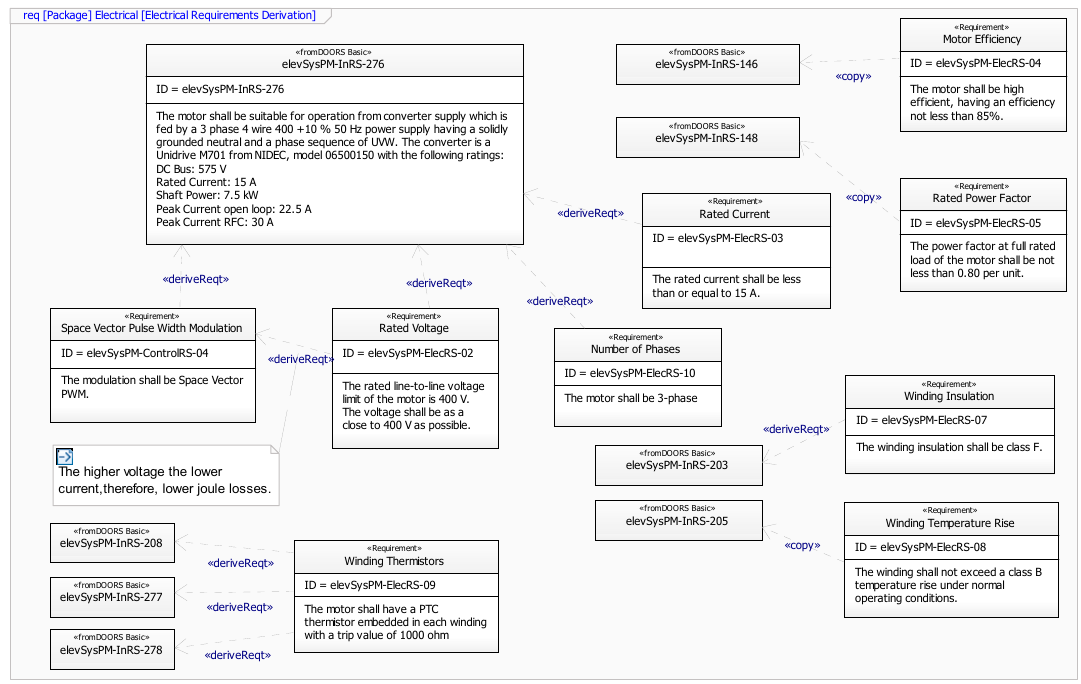
Figure 14. Electrical requirements derivation.